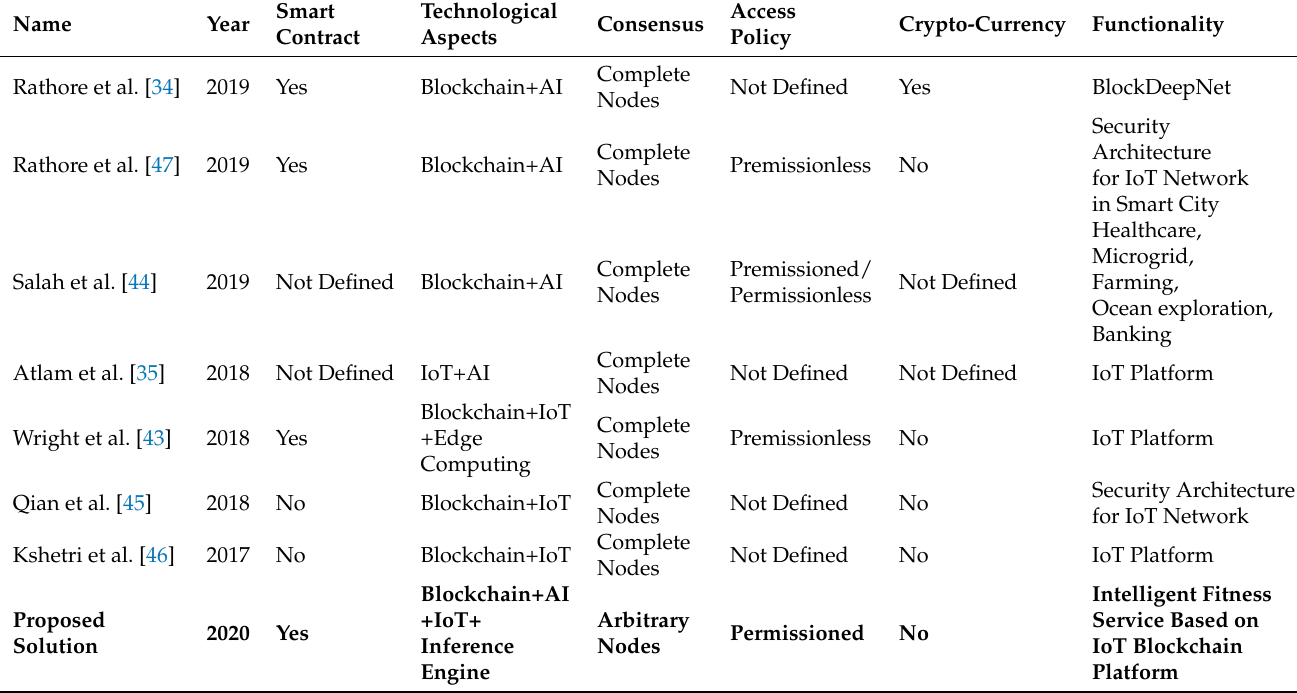
Table 2. Critical analysis of existing studies related to Internet of Things (IoT) blockchain and artificial